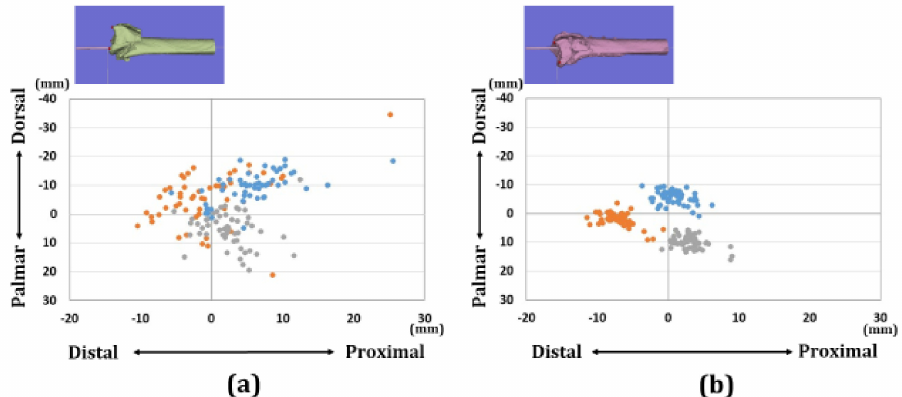
Figure 6. Results of coordinates for the three reference points in the sagittal plane. ( a ) Results of coordinates for the preoperative image. ( b ) Results of coordinates for the postoperative image. The orange dots indicate the radial styloid process: reference point (1). The gray dots indicate the sigmoid notch volar edge: reference point (2). The blue dots indicate the sigmoid notch dorsal edge: reference point